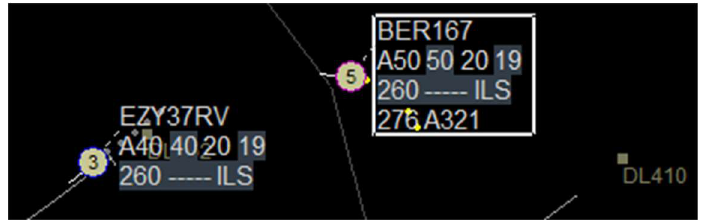
Figure 2. White box around the currently selected aircraft as shown in the radar display.